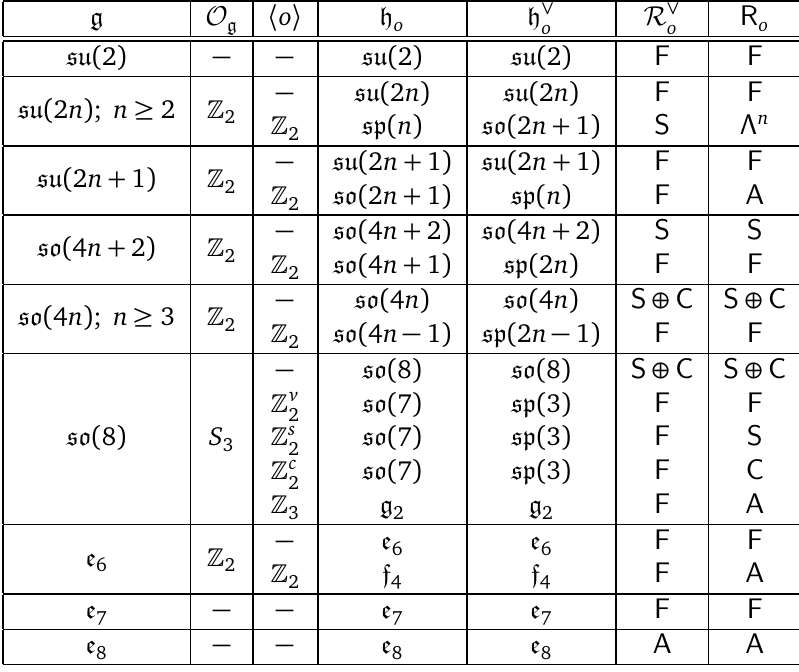
o . R ∨ is a rep- o o . F o